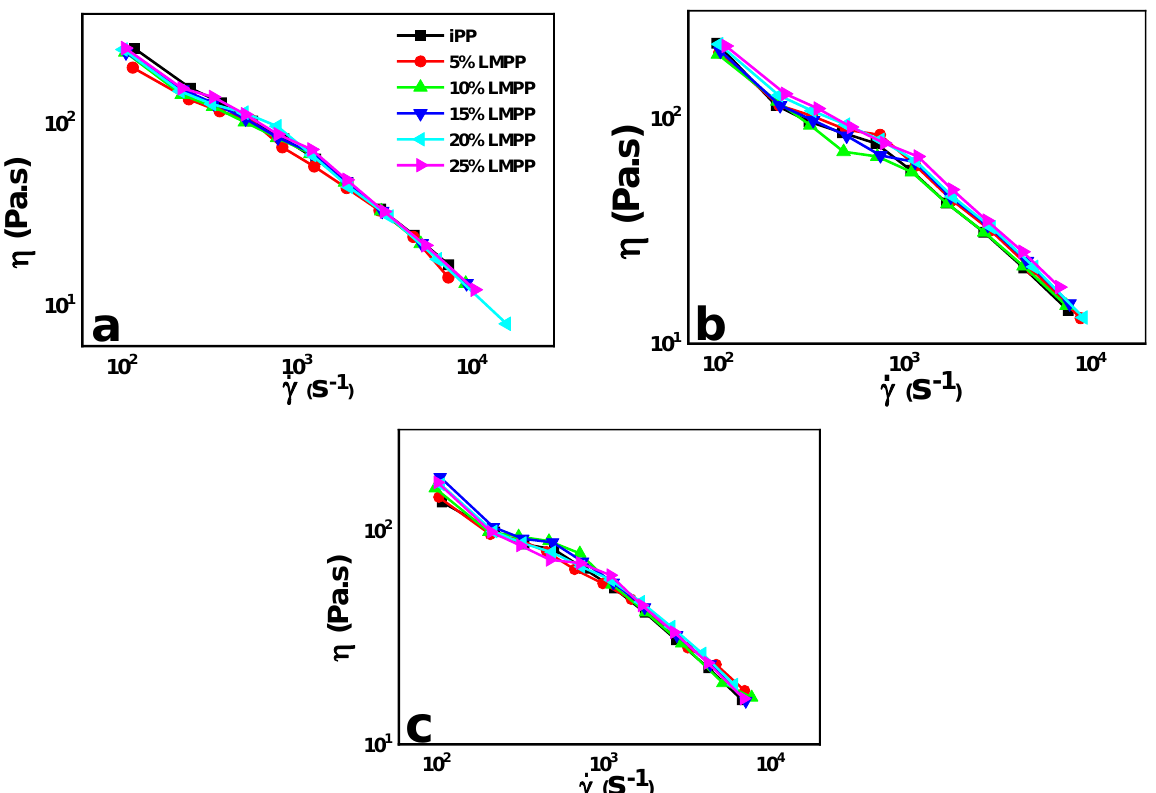
Figure 3. Capillary rheology plot of shear viscosity ( η ) against shear rate ( 𝛾̇) for pure iPP, LMPP and blends at ( a ) 190, ( b ) 200 and ( c ) 210 °C